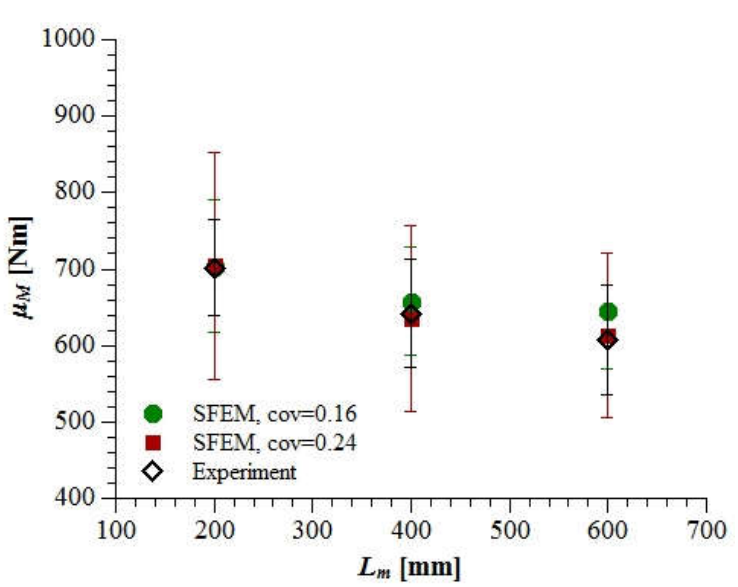
Figure 12. The mean ultimate bending moment ( ± standard deviation) of a beam with increasing span calculated based on SFEM simulations with cov = 0.16 and cov = 0.24 compared with the experimental results of Koide et al. (Copyright Permission, Proceedings of FRAMCOS-3, 1998 and Proceedings of ICASP-8, 2000) [7,8].